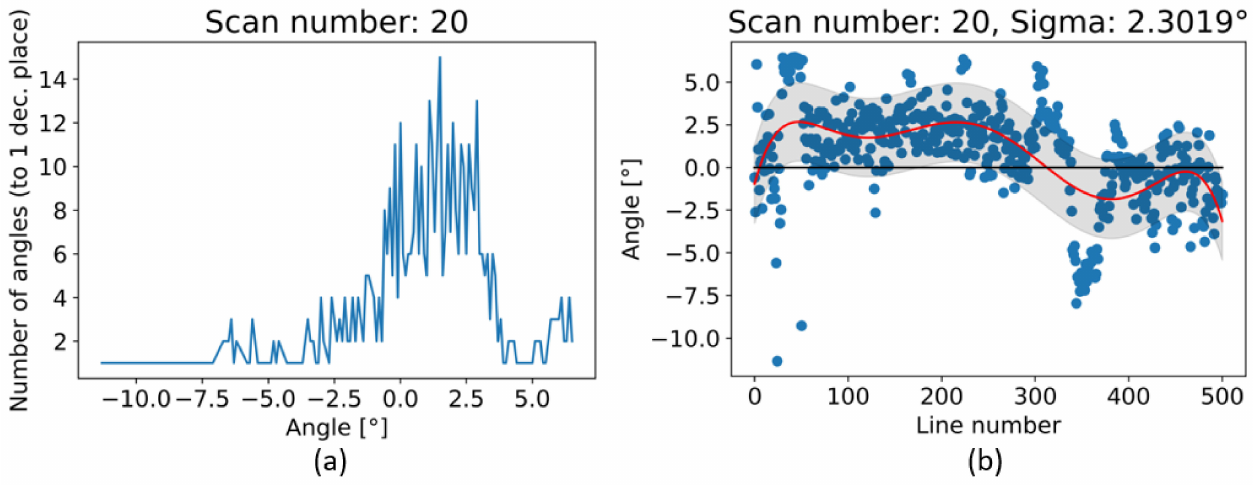
Figure 15. Angles between the tangents for scan number: 20, ( a ) number of angles rounded to one decimal place and ( b ) angles approximated to polynomial of 7th degree with standard